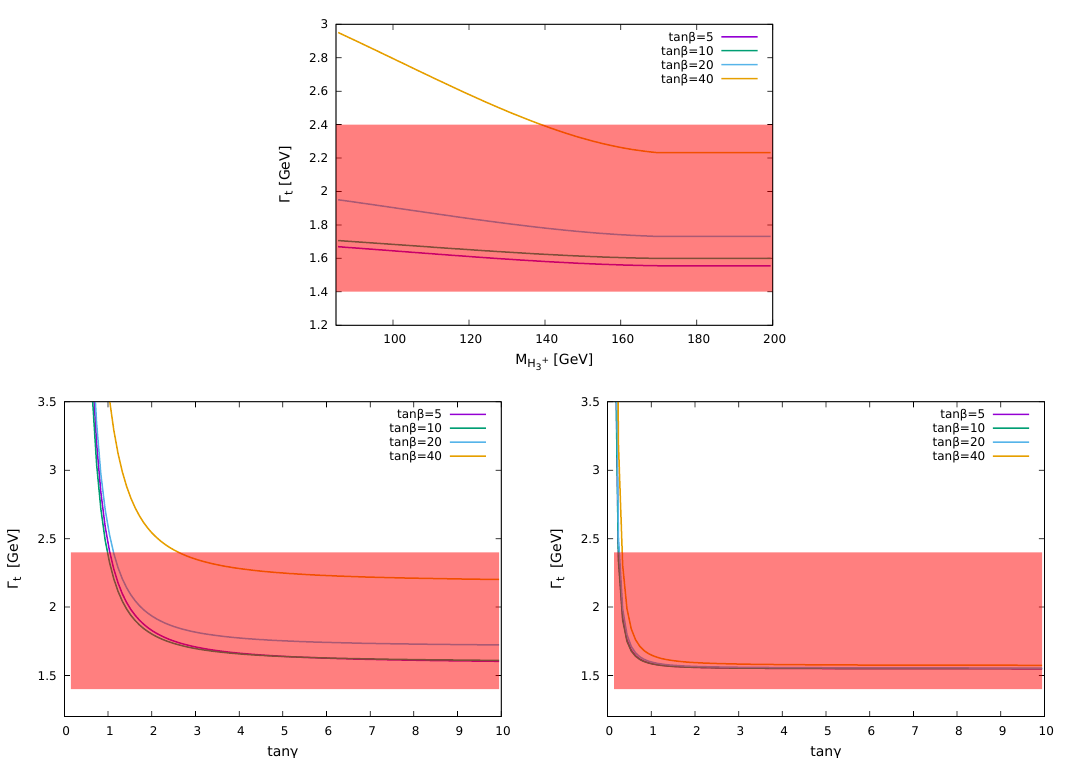
(upper) and tan γ (lower) in the H + 3 = 85 GeV, H + 2 and δ but sets H + 2 = 160 GeV, M = 170 GeV, and δ = 0 . 9 π . The H + 2 H + 3